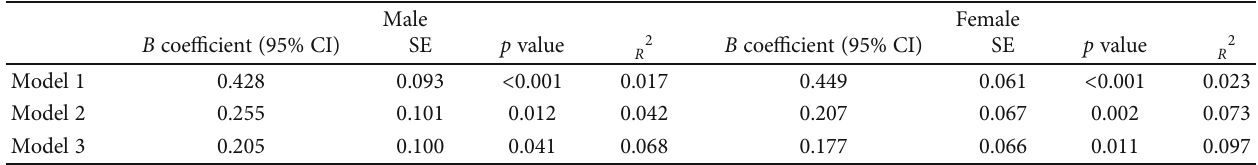
β coe ffi cients are estimated values in mg/dL re fl ecting the complex sample weight. Model 1 on both categories is the unadjusted model. Model 2 is adjusted by age, gender, mean SBP, triglycerides, sedentary hours a day, binge drinking frequency, waist circumference, and smoking state. Model 3 is added by adjusting WBC in Model 2. SE: standard error. Table 4: Complex samples of general linear model for fasting glucose and hs-CRP in males and females. Male